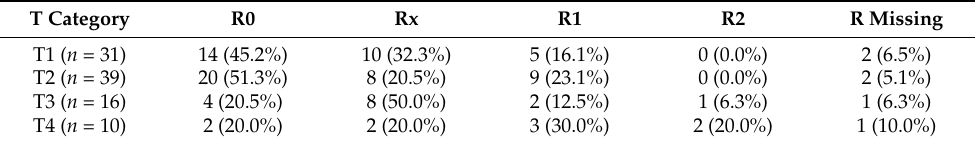
Table 3. Resection status after laser surgery over T category.